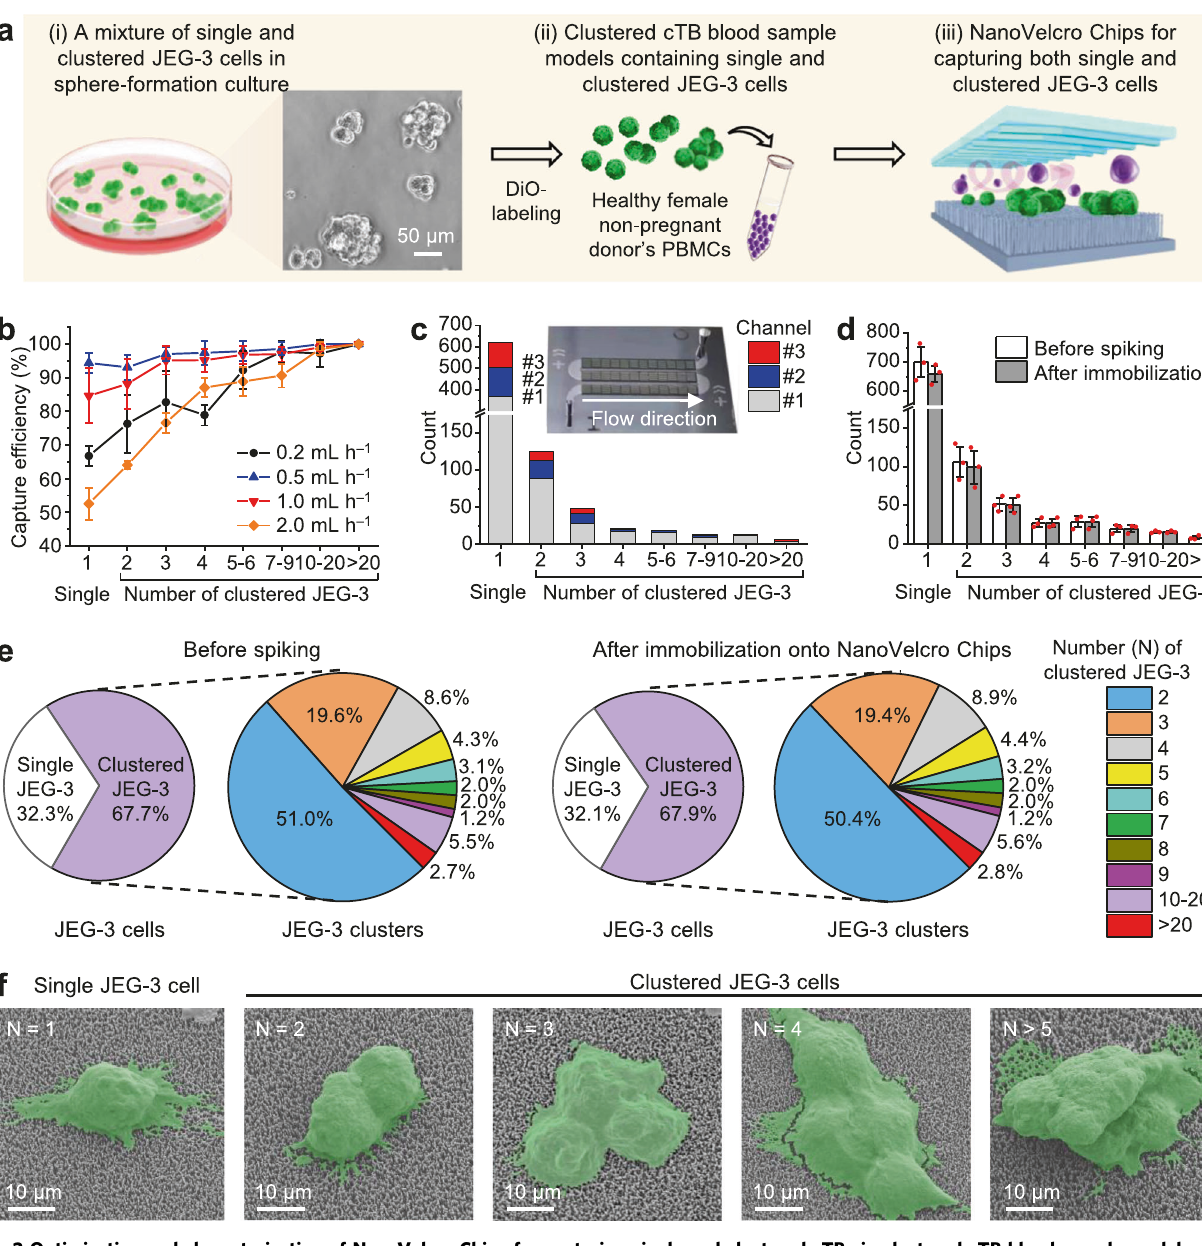
Fig. 2 Optimization and characterization of NanoVelcro Chips for capturing single and clustered cTBs in clustered cTB blood sample models. a A general work fl ow developed for optimization of NanoVelcro Chips for capturing both single and clustered JEG-3 cells. (i) A mixture of single and clustered JEG-3 cells was prepared by culturing under a sphere-formation condition. (ii) Both single and clustered JEG-3 cells were labeled with 3,3 ′ - dioctadecyloxacarbocyanine perchlorate (DiO) and spiked into healthy non-pregnant female donor ’ s peripheral blood mononuclear cells (PBMCs) to prepare clustered cTB blood sample models. (iii) These samples were used for the optimization of NanoVelcro Chips to capture both single and clustered JEG-3 cells. Scale bar, 50 µ m. b The performance of capturing single JEG-3 cells and JEG-3 clusters of varying cell numbers were studied at fl ow rates of 0.2, 0.5, 1.0, and 2.0 mL h ‒ 1 . Data are presented as means± SD of three independent assays. c Distribution of single JEG-3 cells and JEG-3 clusters along the three microchannels of NanoVelcro Chips were studied at the optimal fl ow rate of 0.5 mL h ‒ 1 . Data are from one independent experiment. Inset: a photograph of NanoVelcro Chip showing the connected three channels. d Side-by-side comparison of the distributions of single JEG-3 cells and JEG-3 clusters of varying cell numbers characterized before spiking and after immobilization onto NanoVelcro Chips. Data are presented as means± SD of three independent assays. Error bars represent SD. e Representative pie charts showing the proportions of single and clustered JEG-3 cells, as well as proportions of JEG-3 clusters of varying cell numbers, before spiking (left) and after (right) immobilization. Data are from one representative independent experiment. f SEM images of the single JEG-3 cell ( N = 1) and clustered JEG-3 cells ( N = 2, 3, 4, and >5) captured on the SiNWS of NanoVelcro Chips. Cells are colored in green. Scale bar, 10 µ m. Data are representatives of three independent assays. Source data are provided in the Source data fi